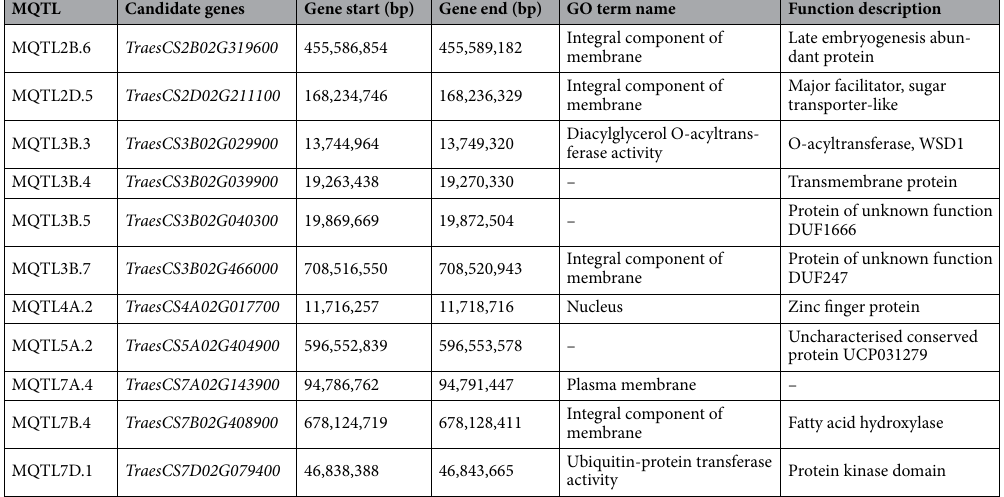
Table 2. Important differentially expressed candidate genes detected in the current